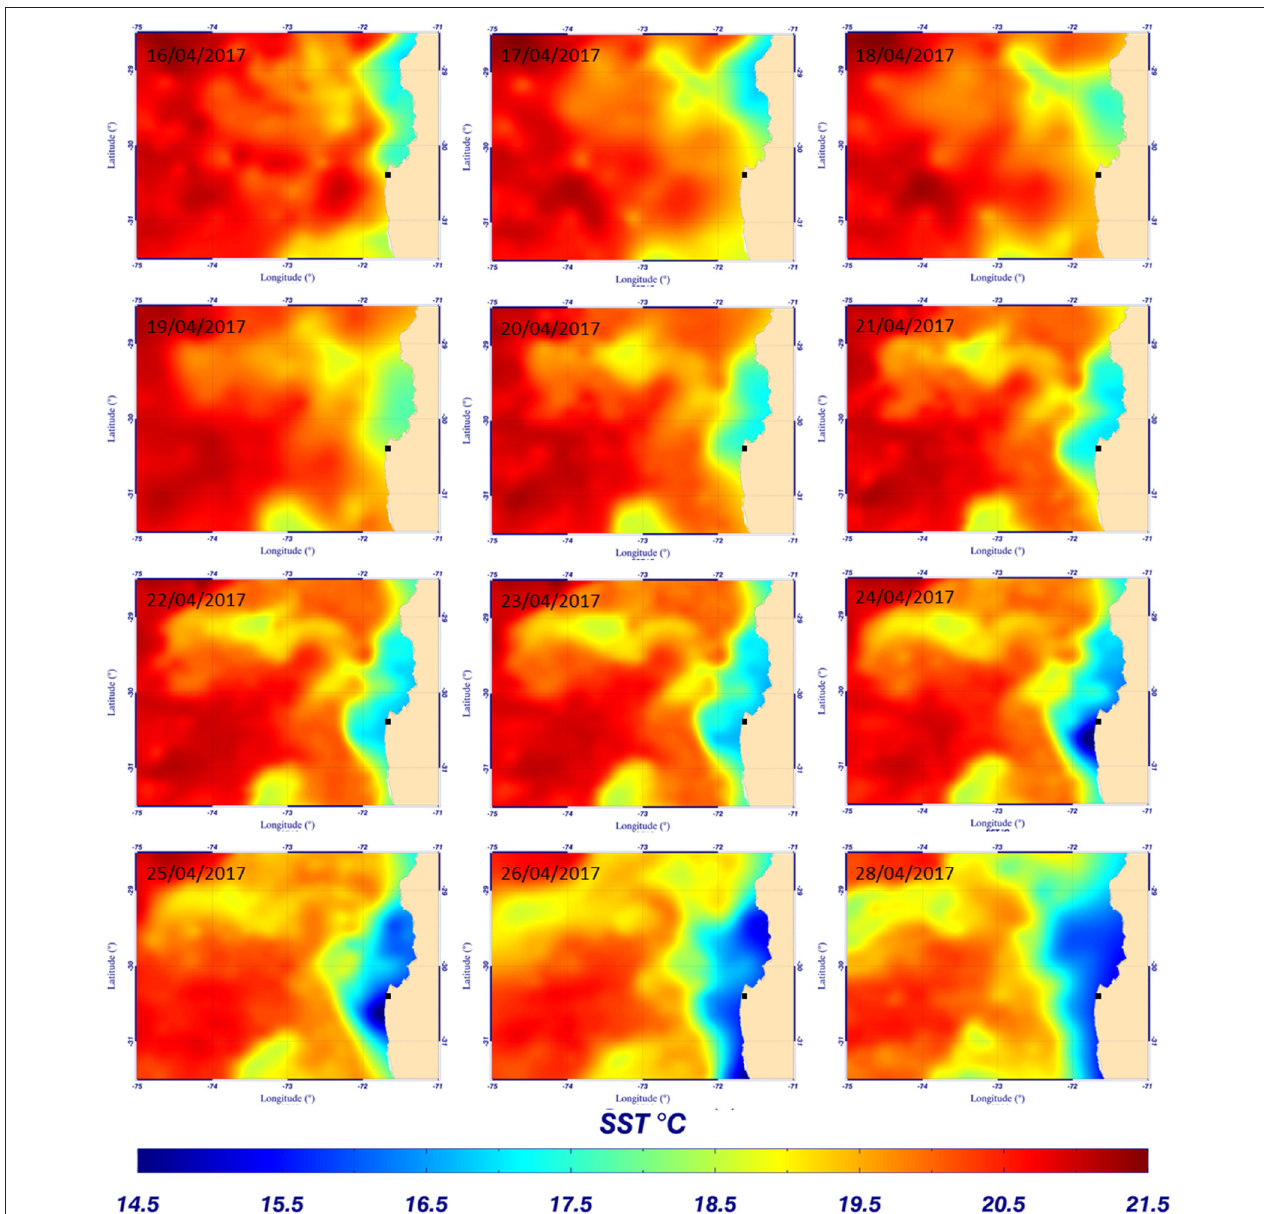
FIGURE 8 | Evolution of sea surface temperature from the Multi-scale Ultra-high Resolution (MUR) (0.01 ◦ ) between the 16th and 28th of April 2017 – (cid:4) indicates the mooring position.